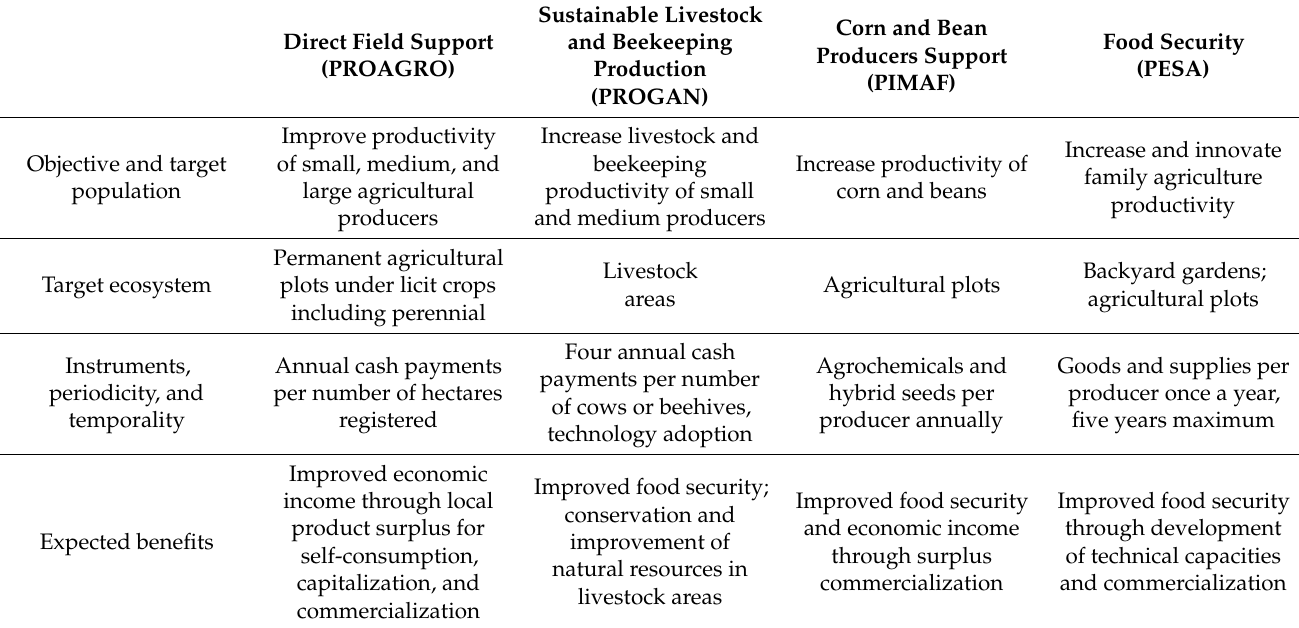
Table 1. Characteristics of the main agriculture programs implemented in Mexico